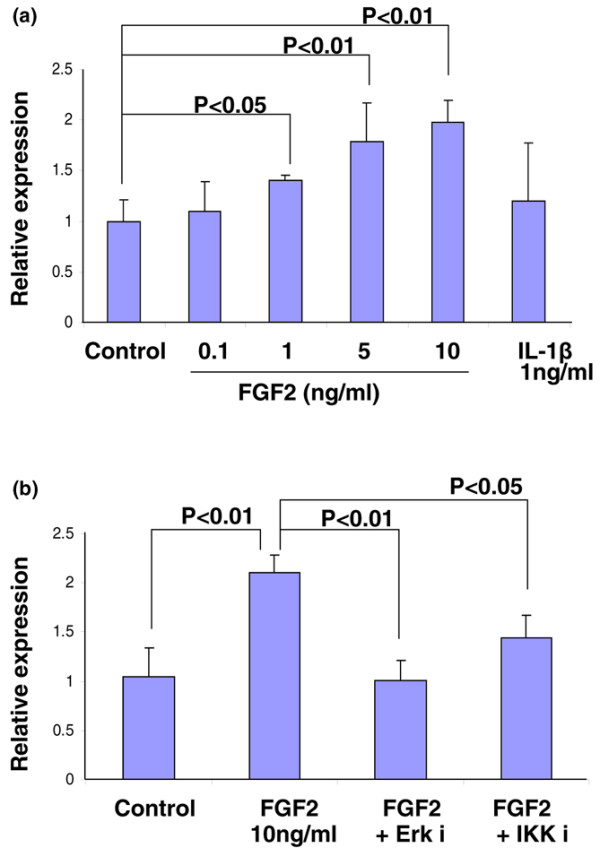
Fibroblast growth factor 2 stimulates noggin via the ERK mitogen-activated protein kinase and NF-κB pathways. Nucleus pulposus cells isolated from bovine intervertebral disc were cultured in a monolayer in 12-well plates at 8 × 105 cells/cm2, and were serum-starved by changing the media to serum-free DMEM/F-12 with antibiotics for 24 hours before treatment. (a) Cells were then treated with 0.1 to 10 ng/ml fibroblast growth factor 2 (FGF2) and 1 ng/ml IL-1β. (b) Serum-starved cells were treated with 10 ng/ml FGF2 in the presence or absence of the chemical inhibitors of ERK (ERKi, 25 μM) or IKK (IKKi, 25 μM). The cells were collected after 24 hours, and total RNA was extracted to perform real-time RT-PCR of the noggin gene. Error bars represent three different donors in three separate experiments.